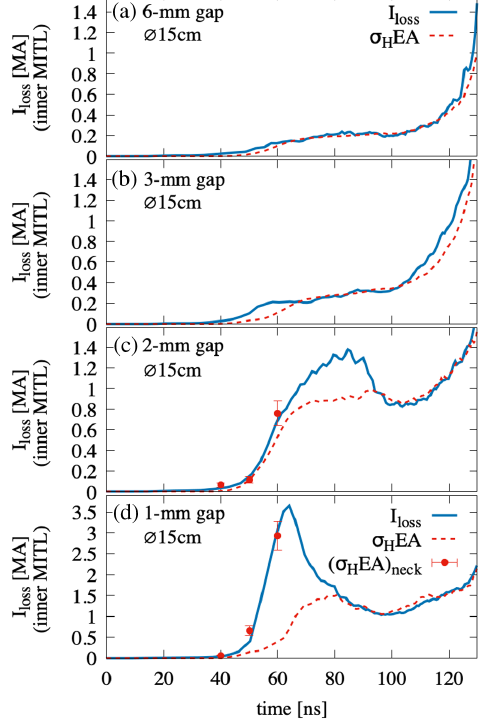
¼ I − I FIG. 14. Current loss ( I ) compared to an loss in load estimate of the Hall current ( σ H EA ) for the four geometries fielded on the ∅ 15 cm convolute (Fig. 8). The volume-average Hall current, given by the dotted lines, has an estimated error of ð t Þ from a single location and average n ð t Þ , 11% from using V e gap both of which fluctuate at the 8% level over 0.5 mm. The points in (c) and (d) are calculated from local values in the minimum AK gap region, averaged over a 7-mm axial region. The mean of the resulting radial distribution is used with statistical errors defined as the 10% – 90% values.